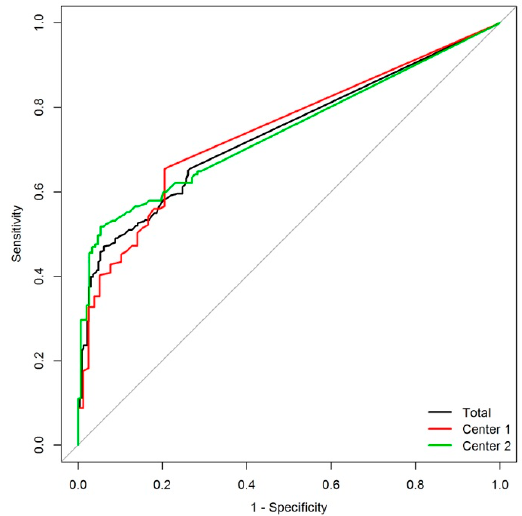
Figure 2. Analysis of the predictive ability—ROC curve analysis for UBC® Rapid at cut-off value 10.0 µg/L for the center 1 (red), center 2 (green), and whole population (black). p -value for comparison between centers = 0.874.